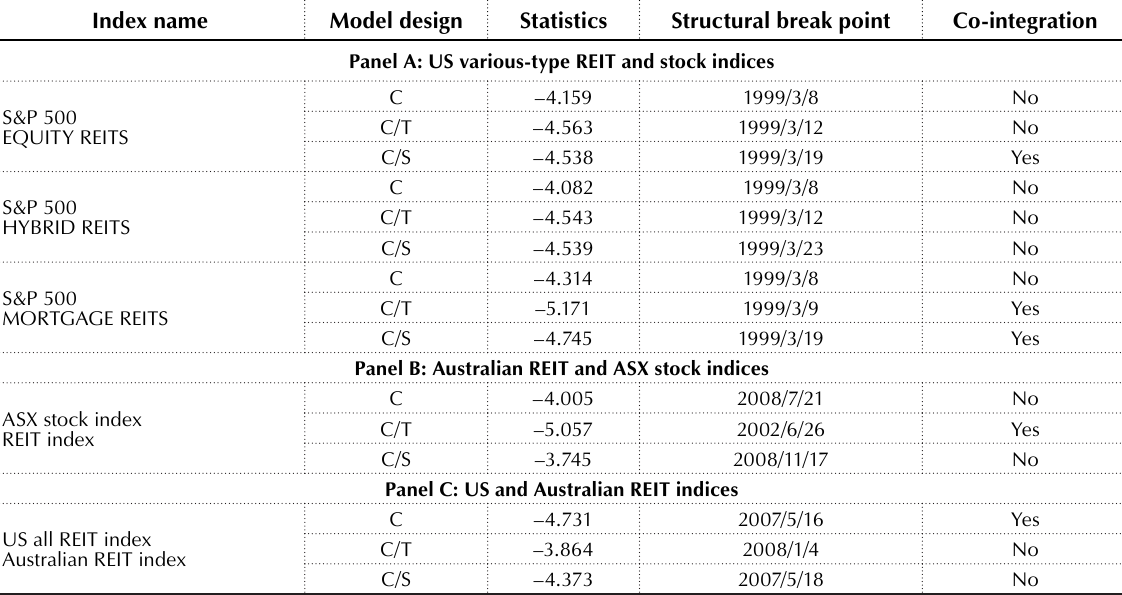
Table 2. Structural break co-integration tests for the REIT and stock indices